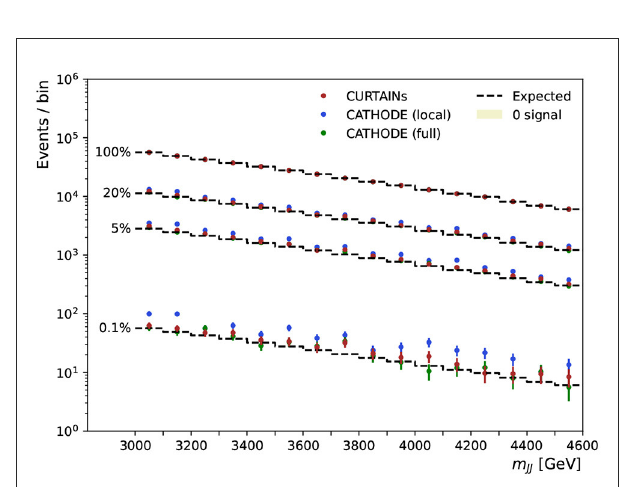
FIGURE9 The dijet invariant mass for the range of signal regions probed in the sliding window, from 3,300 to 4,600 GeV, for the case of zero doping. Each signal region is 200 GeV wide and split into two 100 GeV wide bins. The dashed line shows the expected background after applying a cut on classifier trained using the background predictions from the C URTAIN s (red), C ATHODE (local) (blue), and C ATHODE (full) (green) methods at specific background rejections. Three different cut levels are applied retaining 20, 5, and 0.1% of background events, respectively. The cut values are calculated per signal region using the background